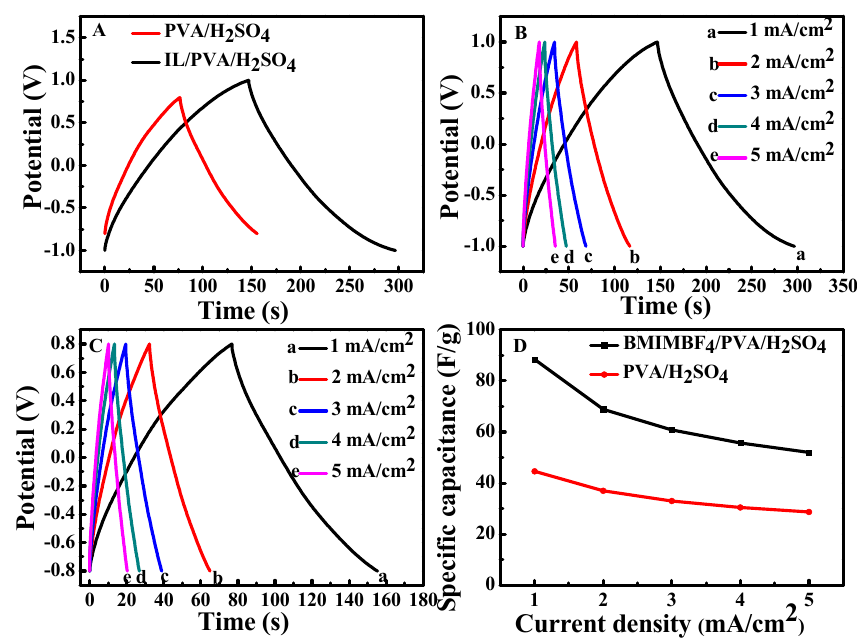
Figure 3. Galvanostatic charge–discharge (GCD) curves of the SSC based on different GPEs at 1 mA/cm 2 ( A ), GCD curves of SSC-IL/ PVA/H 2 SO 4 ( B ) and SSC-PVA/H 2 SO 4 ( C ), as well as the specific capacitances ( D ).